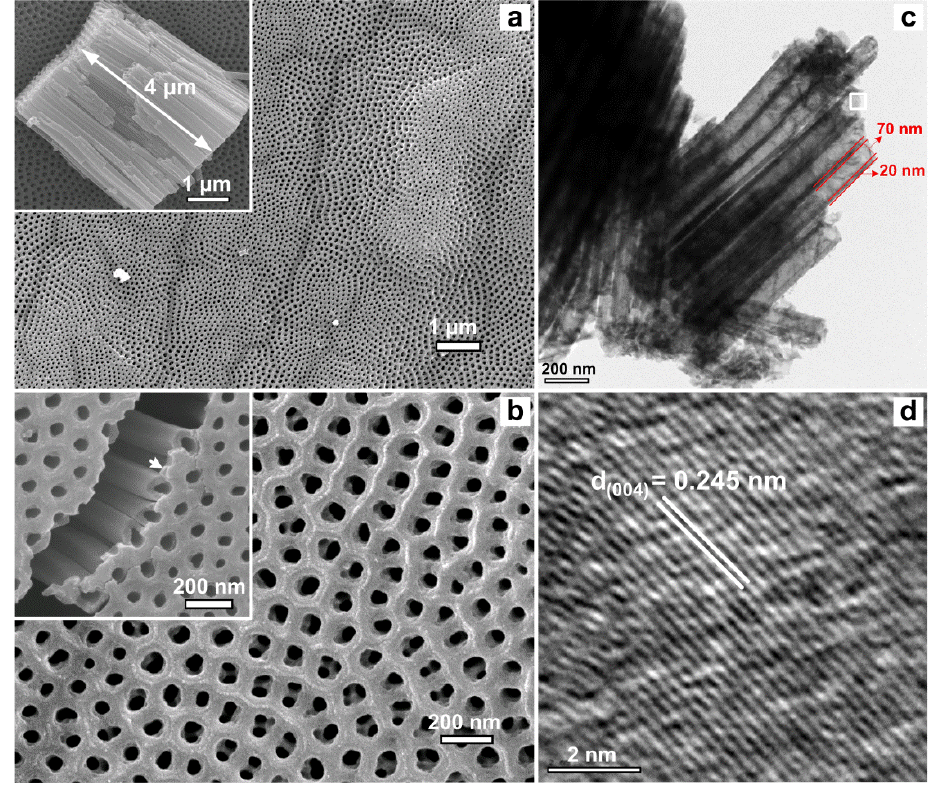
Figure 2. ( a , b ) SEM images of a typical N-doped TiO 2 nanotube arrays (TNAs). The inset in ( a ) is a cross-sectional view of a TNA block. The inset in ( b ) shows grid-like top-layer covering on the TNAs. TEM images of a N-TNAs (9.47 at %): ( c ) a low magnification image at a TNA segment, ( d ) a high magnification image at the square area in ( c ).